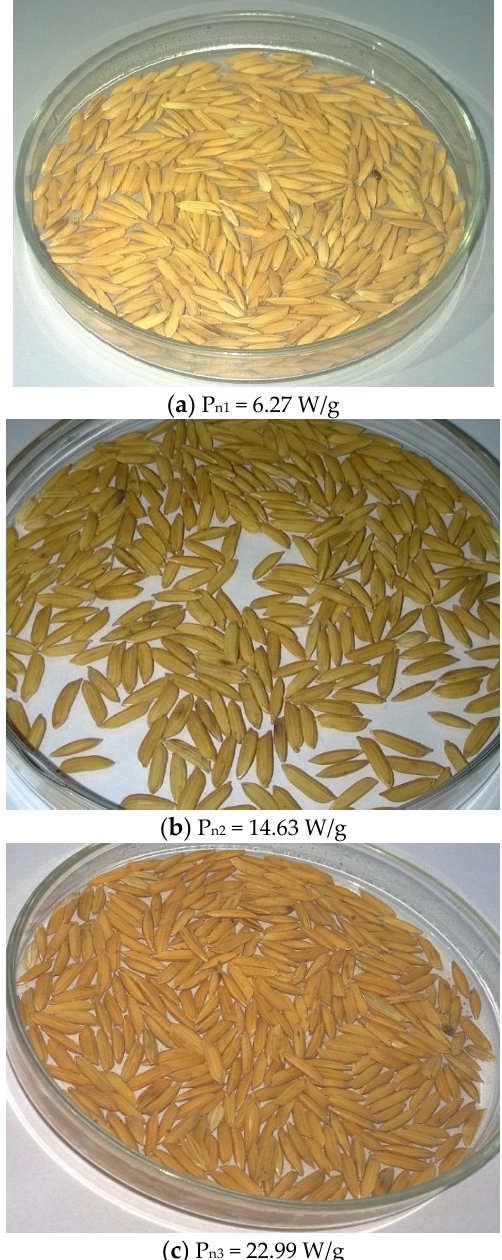
Figure 8. Rice grains from samples 1 ( a ), 2 ( b ) and 3 ( c ) after microwave drying process. Analyzing the rice husks after drying in a microwave oven and oven with forced circulation of hot air, it is possible to highlight some effects of the drying process on the final quality of dry rice grains: appearance of several grains with dark color and the presence of black spots on the husk and extremities, due to the high temperature reached on the surface of the grains in some moments of the drying process, mainly for sample 3, where the surface temperature reached the 130 ◦ C mark at the instant of time t = 64 min. Figure 9 shows the rice grain after convective drying process at 60 ◦ C in oven with forced circulation of hot air.